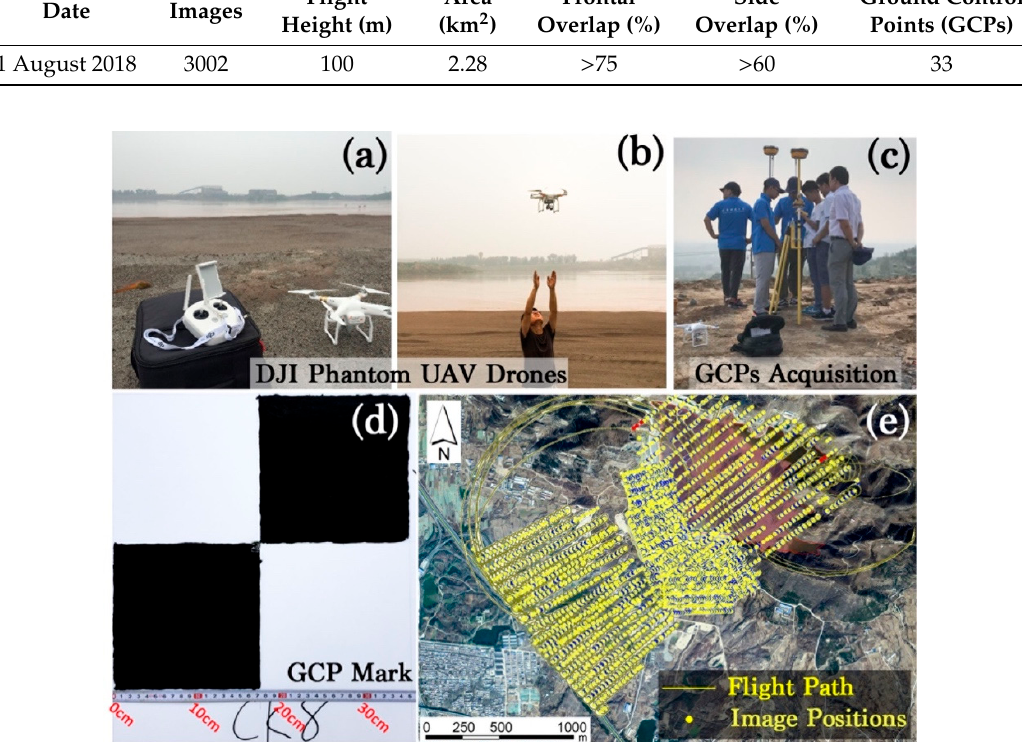
Figure 4. Photogrammetry data acquisition: ( a , b ) the DJI Phantom unmanned aerial vehicle (UAV) drones and field surveys, ( c , d ) ground control points (GCPs) acquisition, ( e ) flights implementation and images acquisition. Table 1. Unmanned aerial vehicle (UAV) photogrammetry data acquisition of the study site.